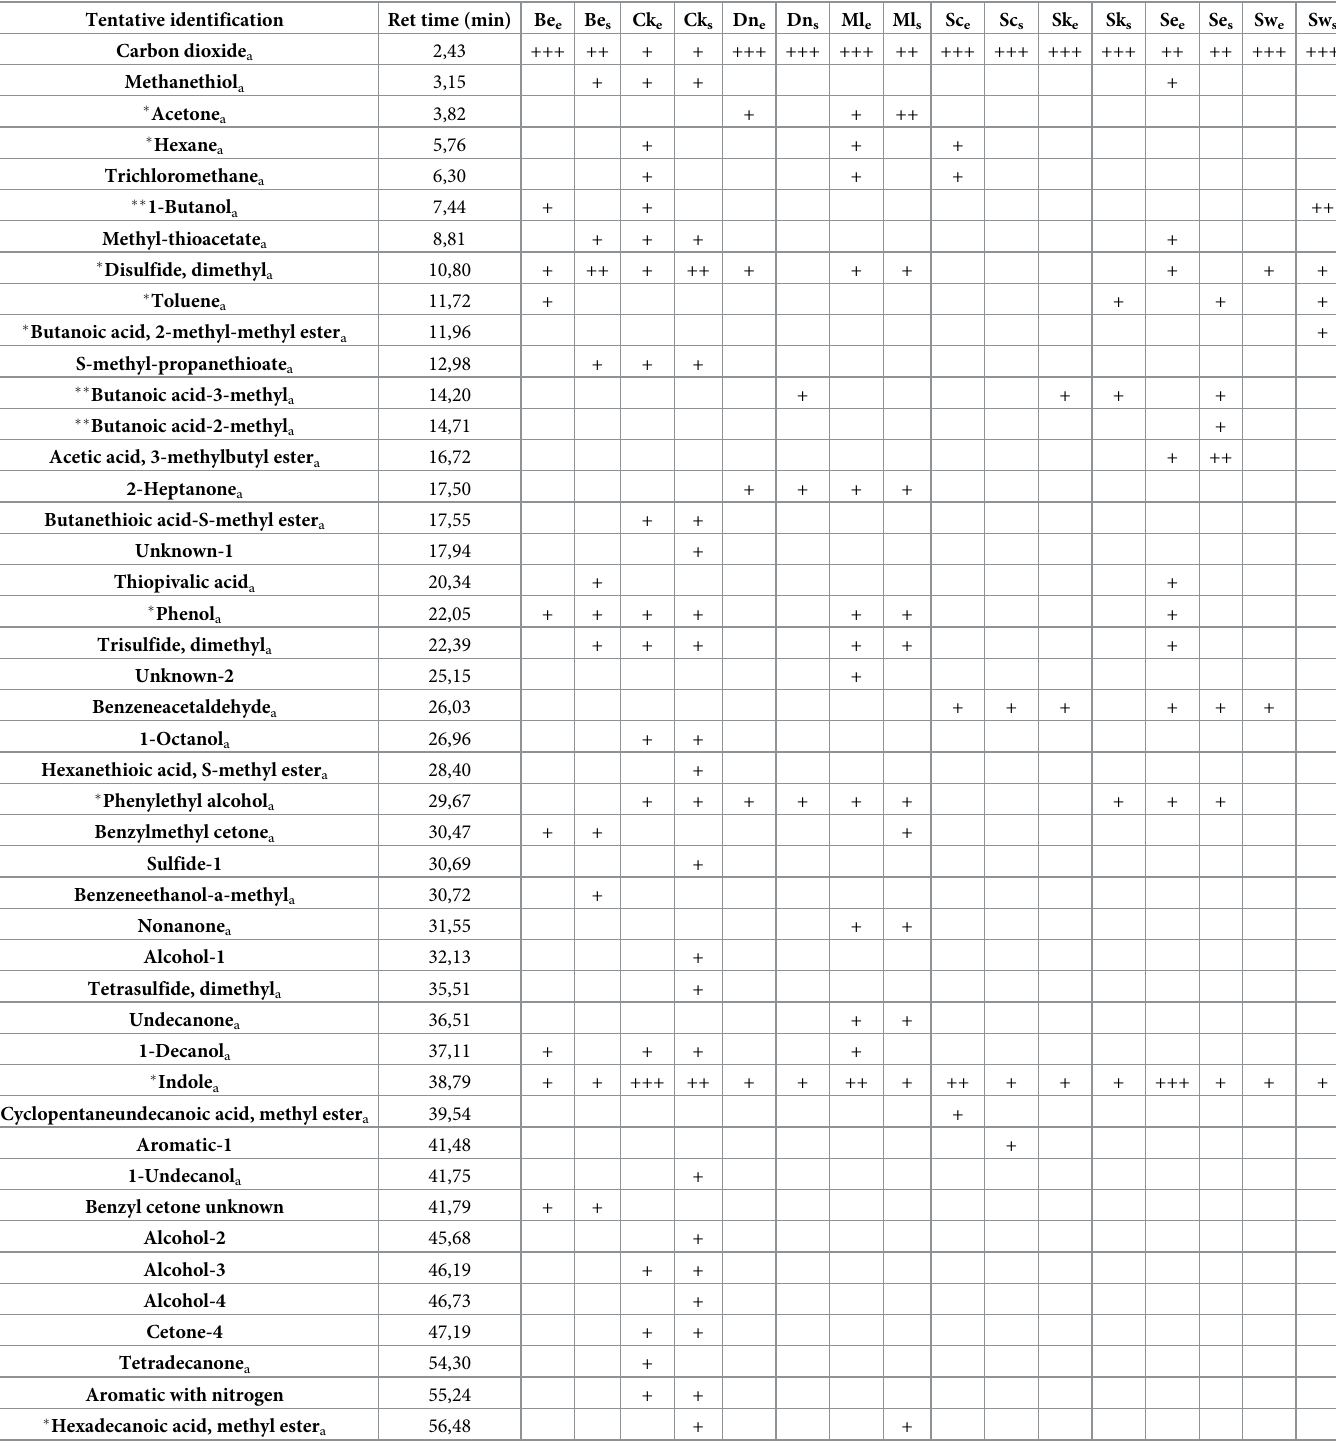
Table 1. Tentative identification of VOCs released in vitro by the eight bacterial strains tested. VOCs are listed according to their retention times. Tentative